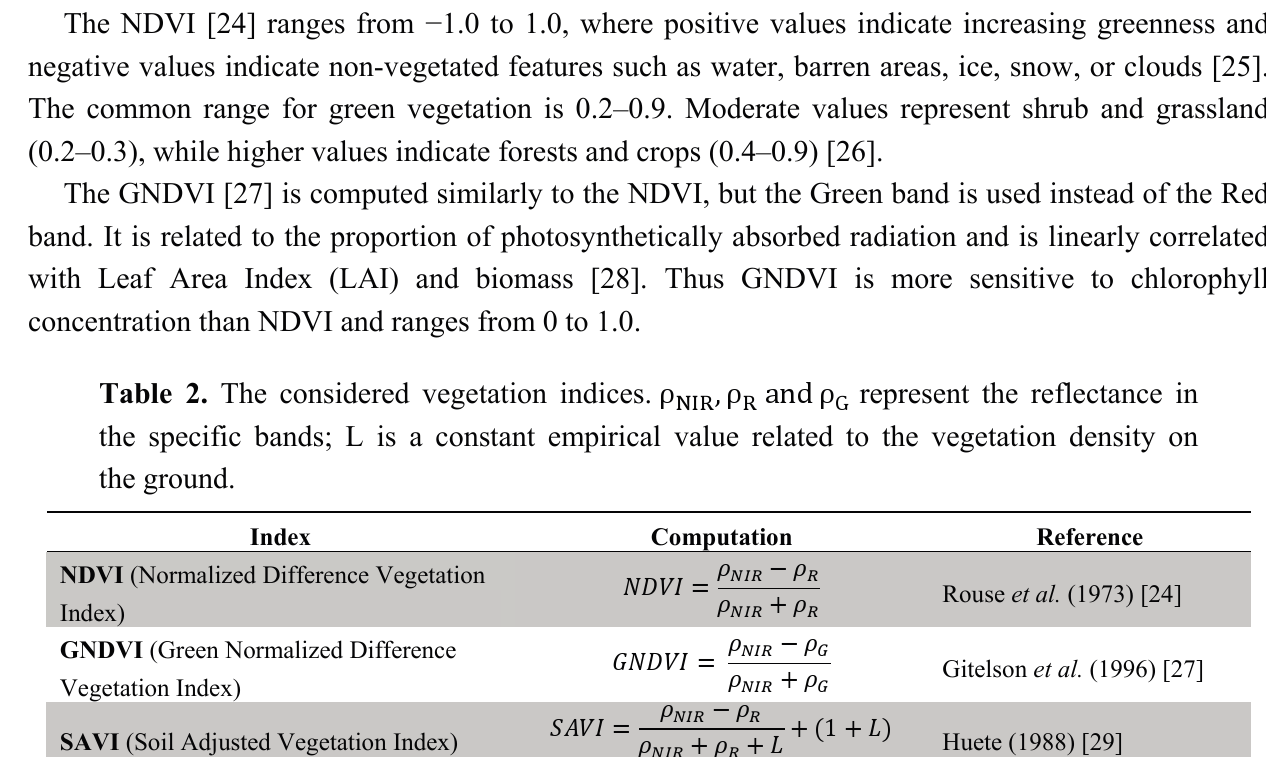
represent the reflectance in , ρ and ρ (cid:2898)(cid:2893)(cid:2902) (cid:2902) (cid:2891)